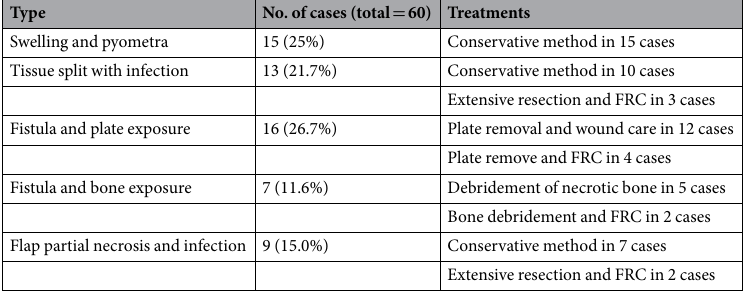
Table 4. Postoperative infection and corresponding treatments. * Conservative method: debridement (remove of the necrotic soft tissues), dressing change everyday continued for about two weeks, and antibiotic prescription; * FRC: flap re-coverage.